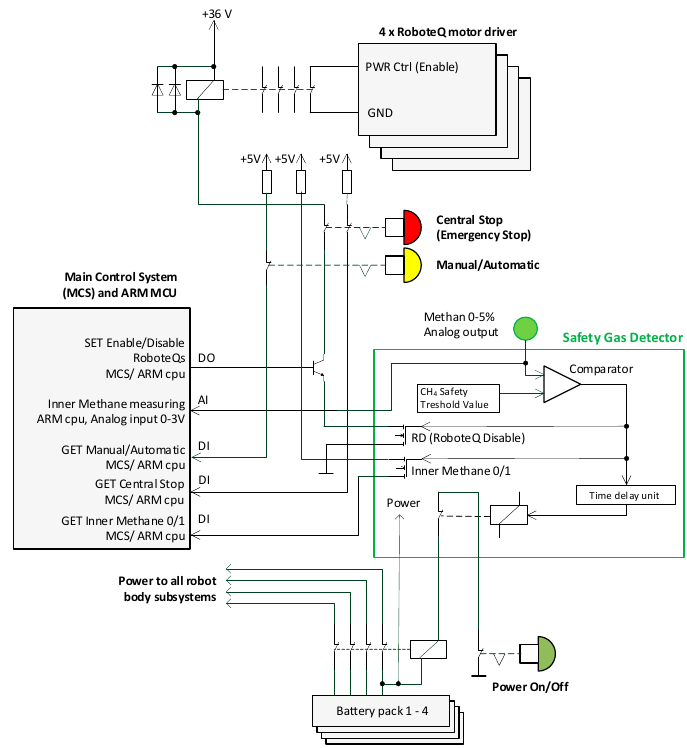
Figure 13. Implementation of safety gas detector into the robot subsystems—simplified diagram.